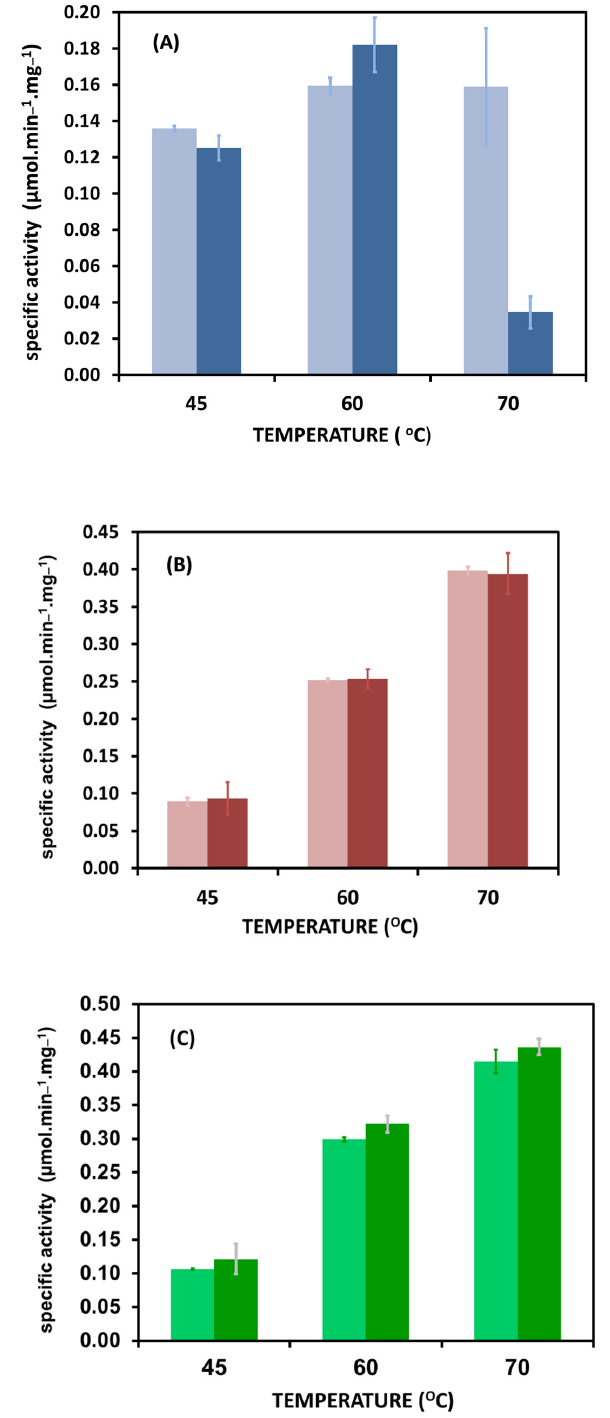
Figure 11. Specific activity before and after pretreatment at 45 °C, 60 °C and 70 °C for 15 h of ( A ) free CALB lipase ( without treatment, treated); ( B ) Novozym 435 ( without treatment, treated); ( C ) CALB immobilized on Ns SiO 2 ( without treatment, treated). The esterification of rac -ibuprofen with ethanol was carried for 9 h at the temperature of the treatment.